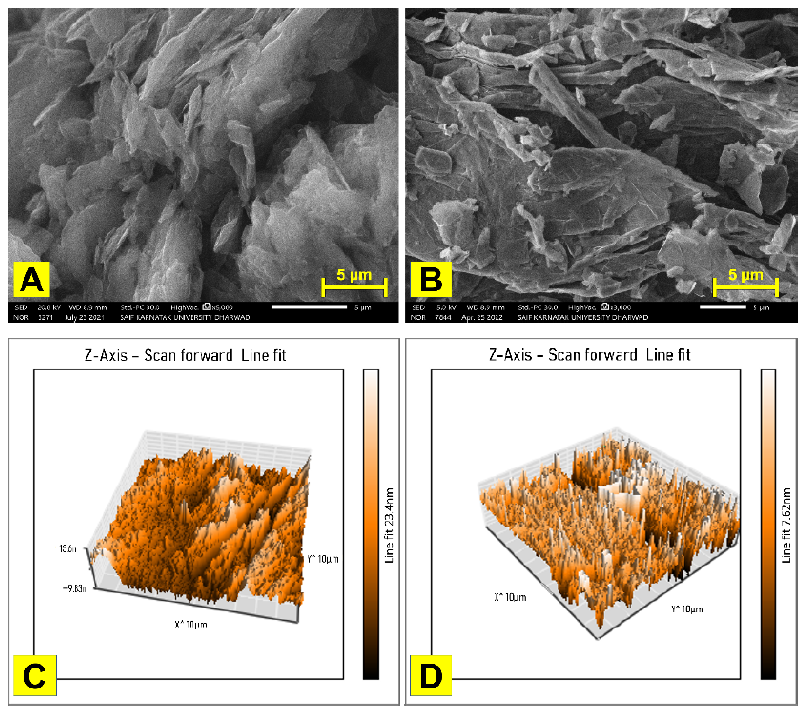
Figure 2. SEM images of ( A ) the carbon matrix and ( B ) the graphene-modified carbon matrix. ( C ) ( C ) AFM image of bare CPE. ( D ) AFM image of AFM image of bare CPE. ( D ) AFM image of G/CPE.